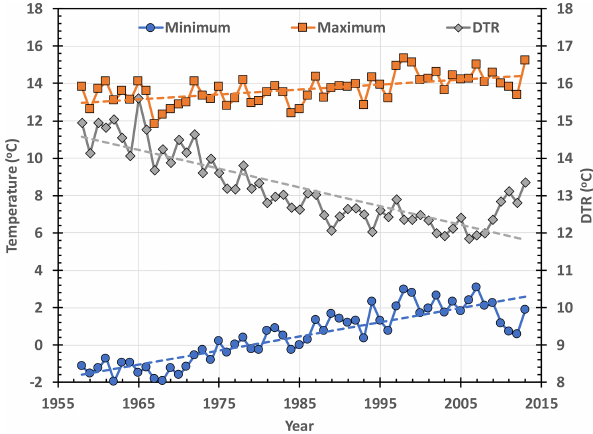
Figure 3. Increasing significant trends in the area-averaged annual mean daily maximum and minimum temperatures combined from the two stations, Yongii and Wulate in Table 3 and the decreasing significant trend in mean DTR for the period 1958 to